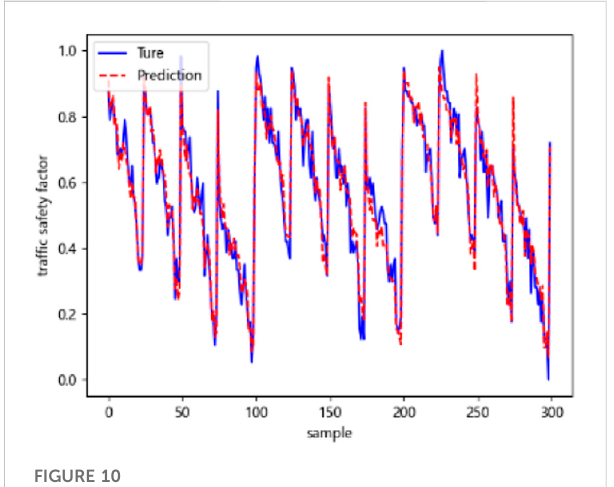
FIGURE 12 RNN model calculation results.